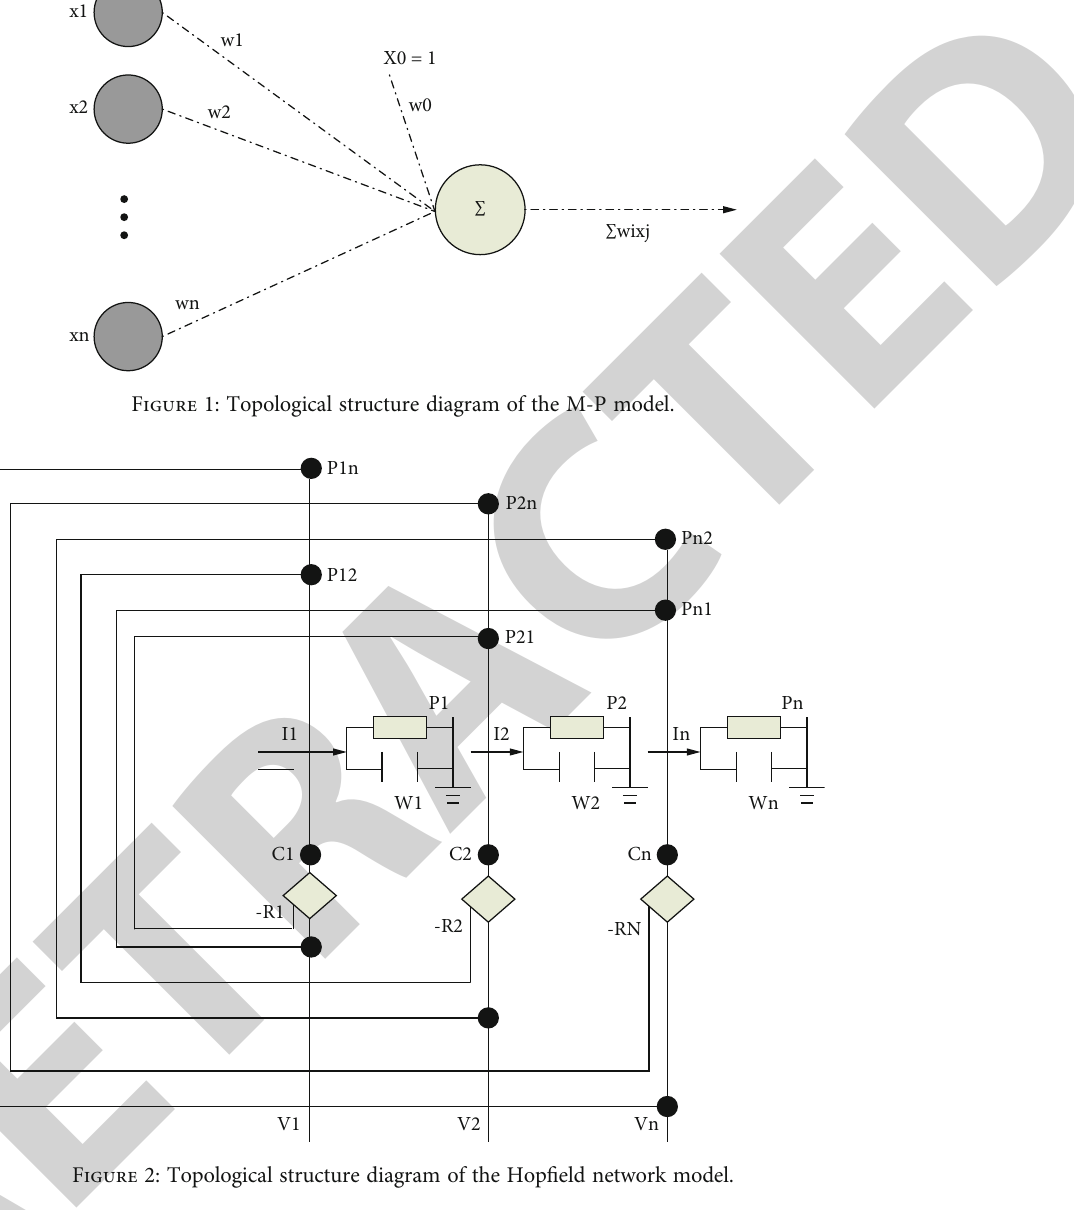
Figure 2: Topological structure diagram of the Hop fi eld network model.